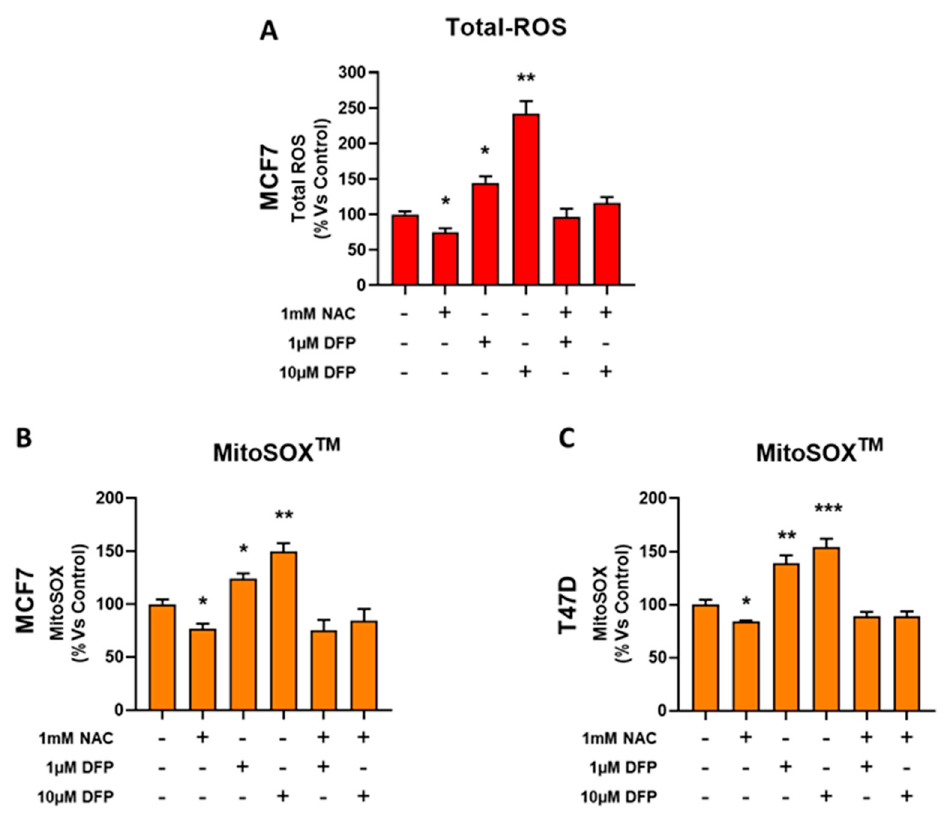
Figure 8. NAC reverted the DFP effect by restoring REDOX balance. ( A ) Note that DFP increases the total cellular ROS production in a concentration-dependent manner (from 1 μ M to 10 μ M). In the presence of 1 mM of NAC, the effect of DFP was reverted and the total cellular ROS content was similar to the control (vehicle alone) . * p <0.01; ** p < 0.001 . ( B – C ) Similar trends were obtained by measuring the mitocondrial ROS content in MCF7 and T47D cells. Here, again the effect of DFP was reverted by NAC at concentrations of 1 mM and 10 mM. * p <0.01; ** p < 0.001 ; *** p <0.0001.